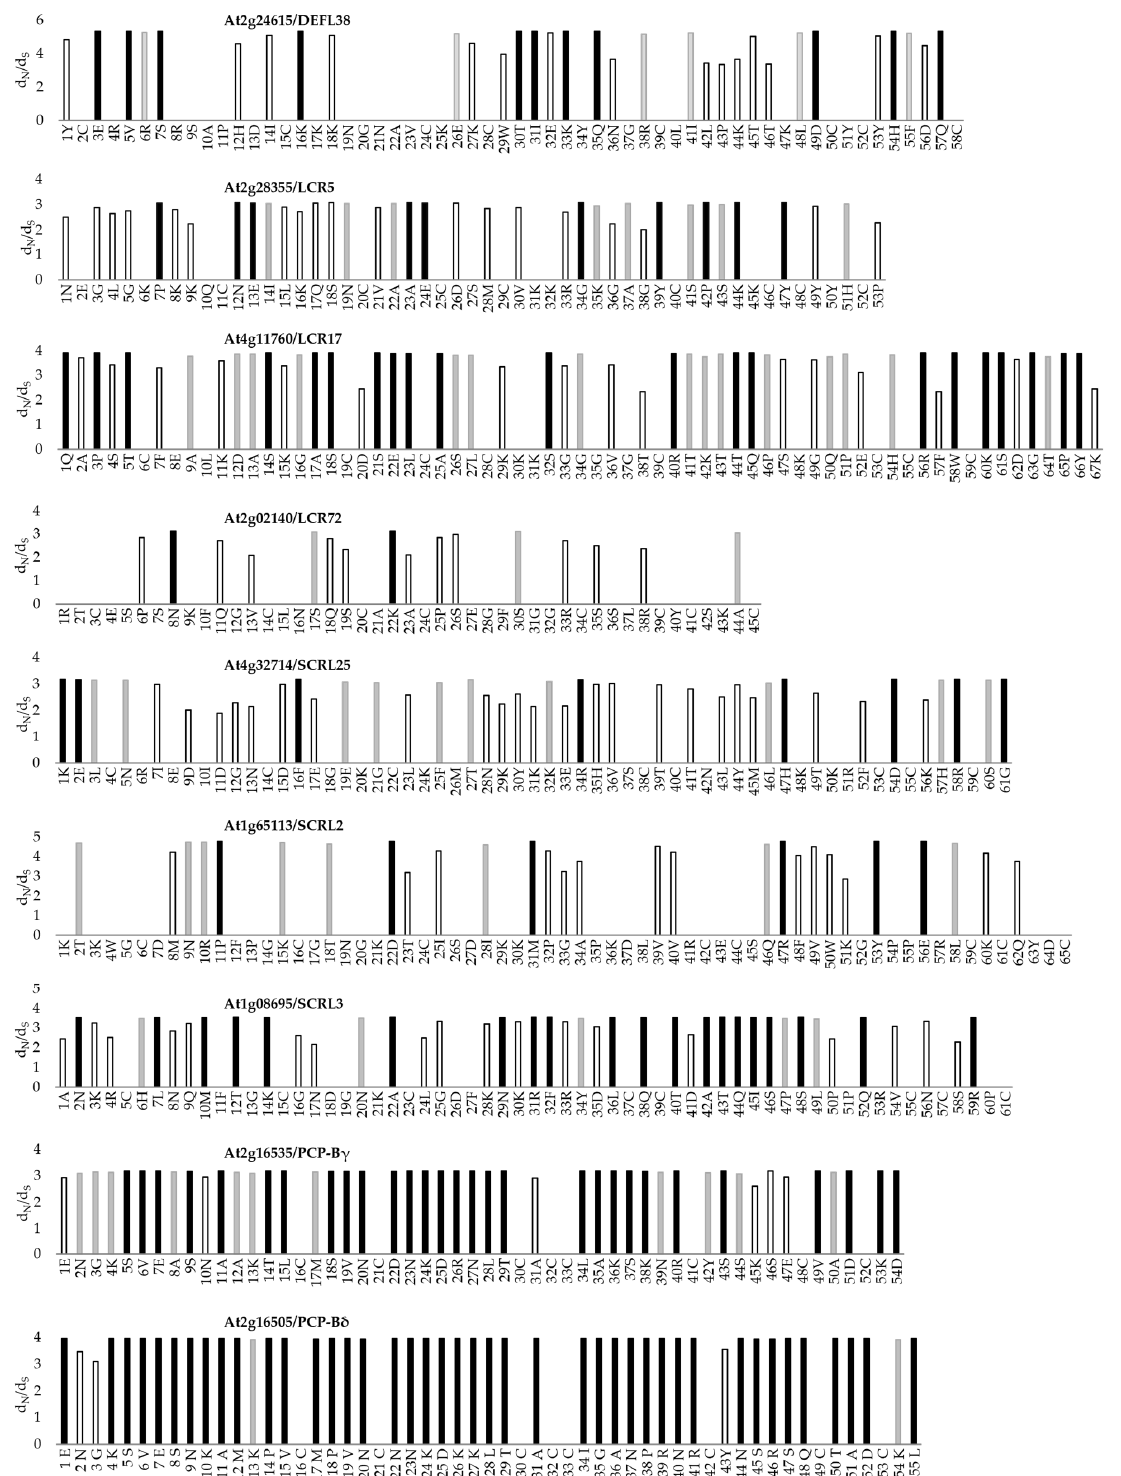
Figure 4. Positive selection and ω (d N /d S ) of codon sites with a posterior mean ω > 1 of nine pollen coat cysteine-rich proteins (CRPs). Site-specific selection analysis was based on model M8 in the codeml programme of the PAML package [46]. The amino acid residues are shown below the x -axis. The ω values with a Bayesian posterior probability greater than 99% are represented by black bars, ω values with a Bayesian posterior probability greater than 95% are represented by grey bars, and ω values with a Bayesian posterior probability less than 95% are represented by empty